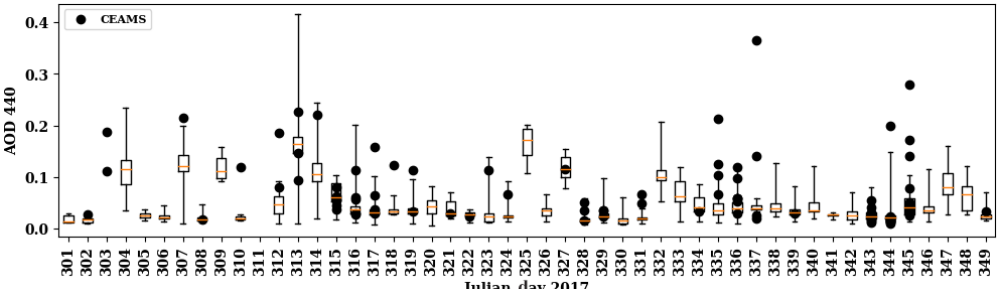
Figure 5. Box-and-whisker plots showing the distribution of AERONET AOD at 440nm (870nm comparison Fig. S3) at all sites in northern Colorado (listed in Table S1; not all sites have values for every day) for each day from 28 October–15 December 2017. Box denotes 1st and 3rd quartile, whiskers denote maximum and minimum, and orange line shows median. CEAMS AOD values at 440nm are overlaid as black dots.